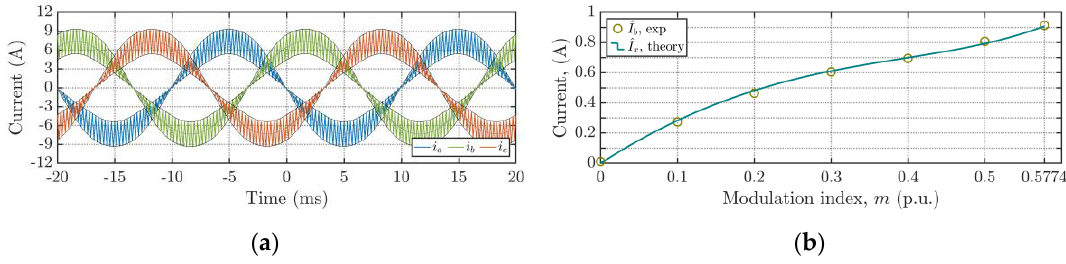
Figure 40. ( a ) Phase currents with primary (black) and secondary (gray) envelopes in case of DPWM1 ( m = 1/√3); ( b ) Phase current ripple rms in case of DPWM1.